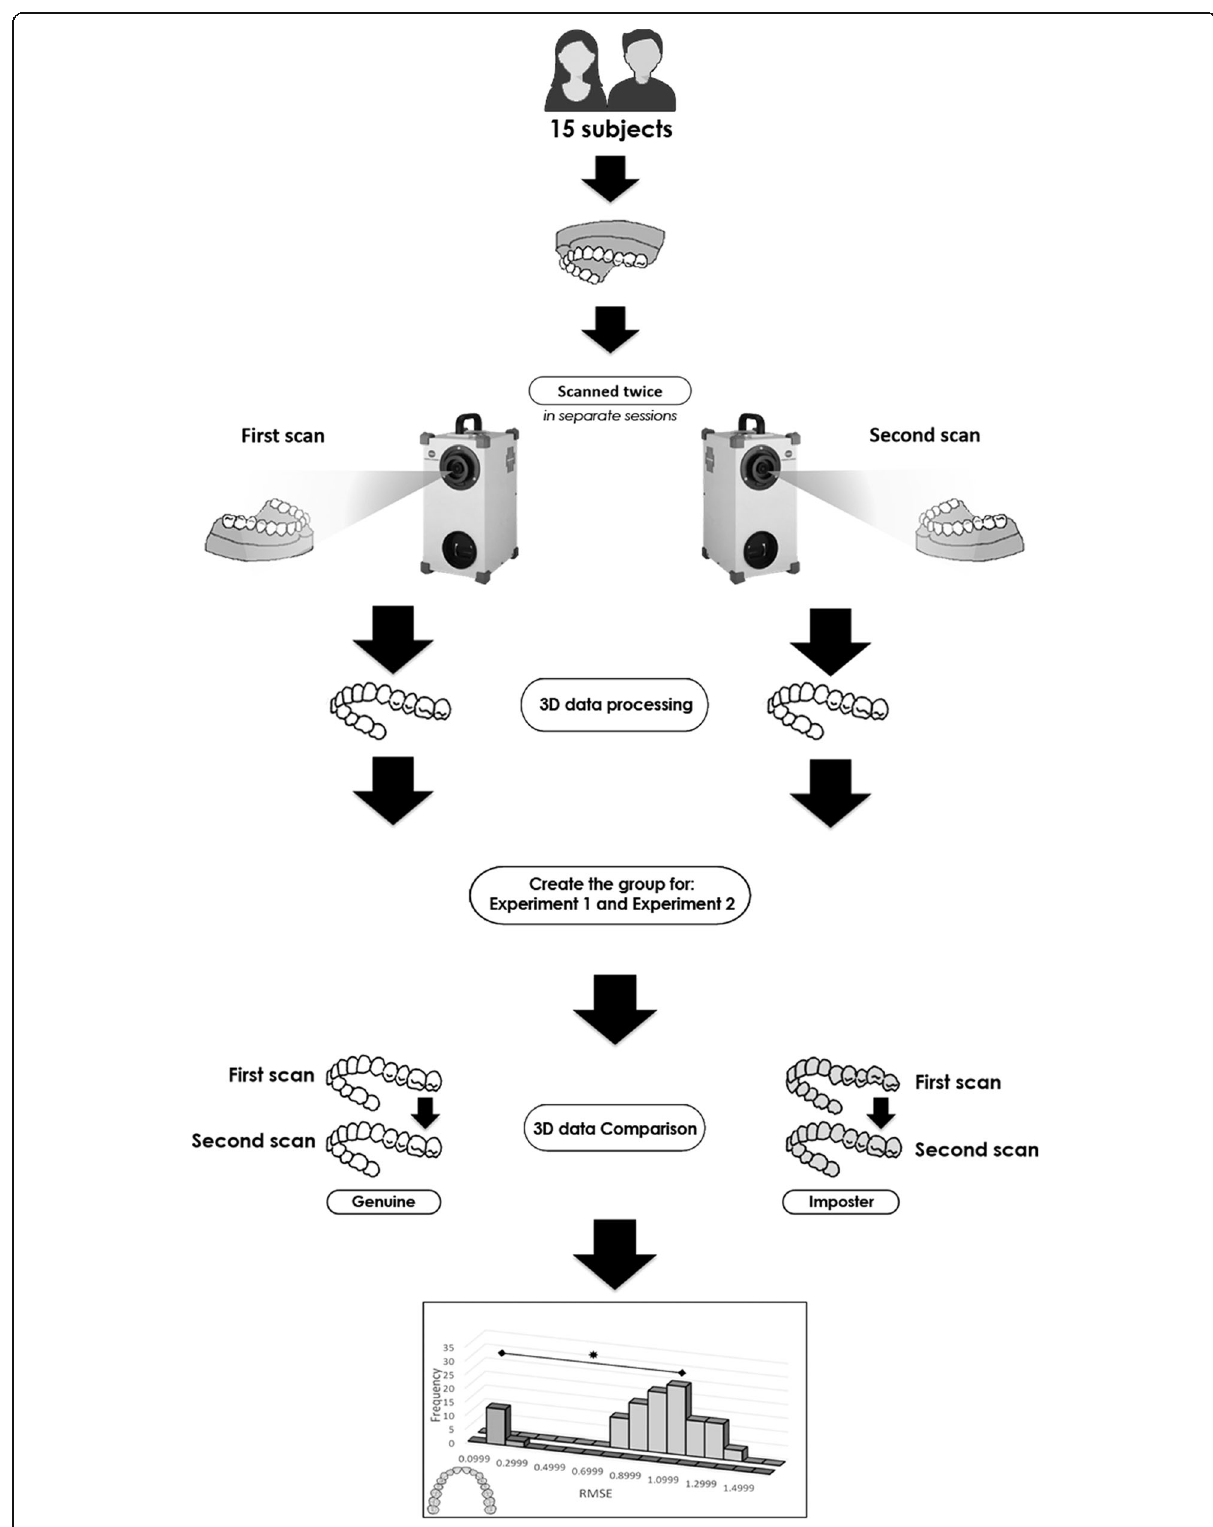
Fig. 4 An overview of 3D data acquisition, processing, and